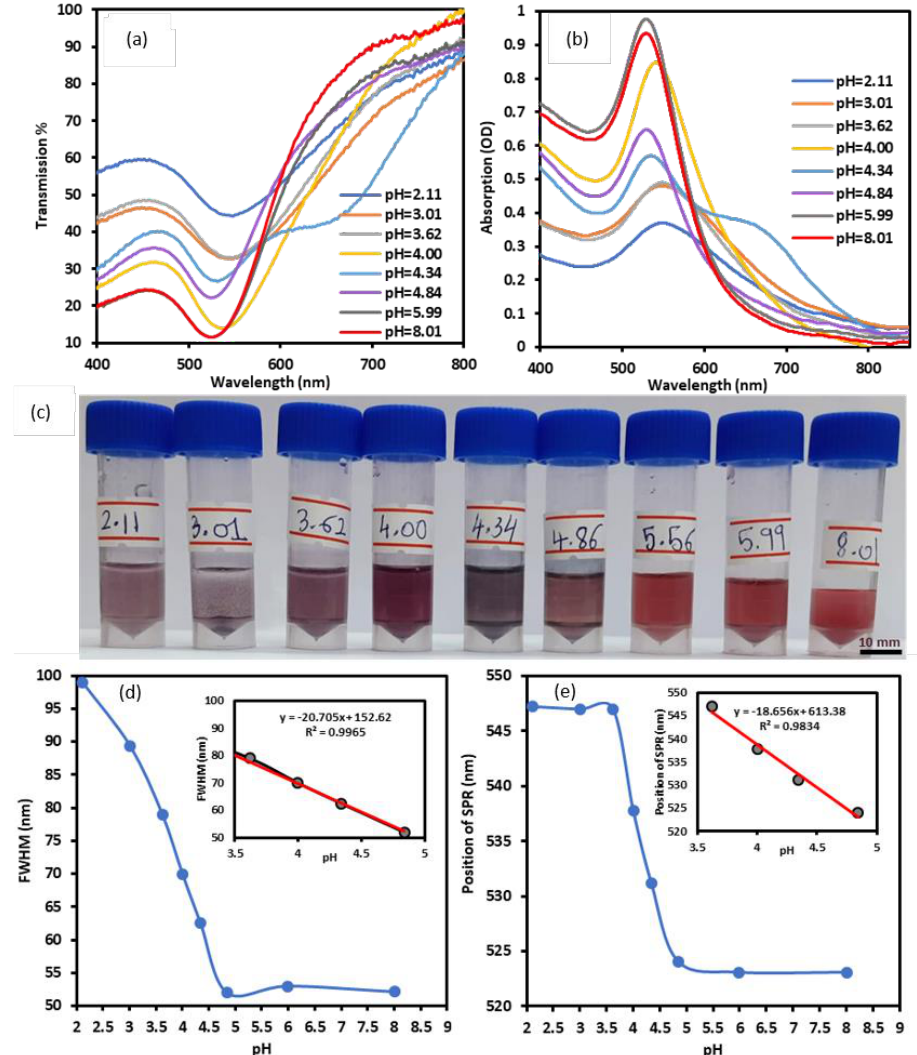
Figure 2. Optical characterization of GNPs-MPA solutions at different pHs ranging from 2 to 8: ( a ) Transmission and ( b ) Absorption spectra of the solutions at distinct pHs. ( c ) Images of the solutions. Extracted information from the optical spectra: ( d ) FWHM and ( e ) Position of SPR as a function of pH. Inset shows the calibration curves in the NPs’ pH-responsive region.